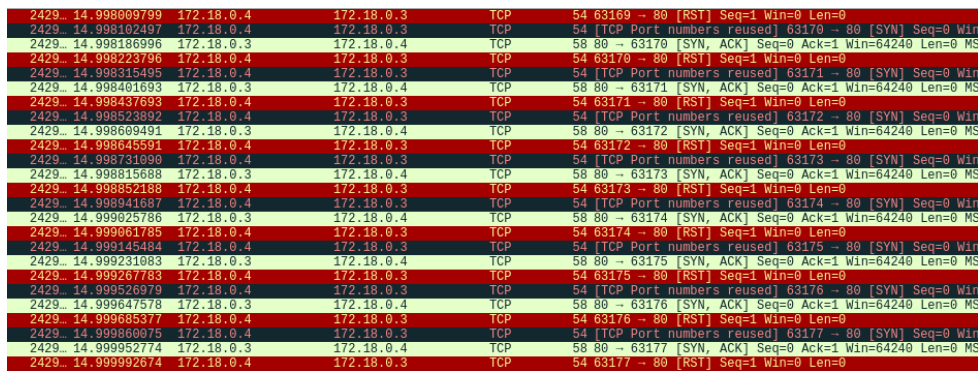
Figure 21. Traffic classified as malicious in Wireshark .